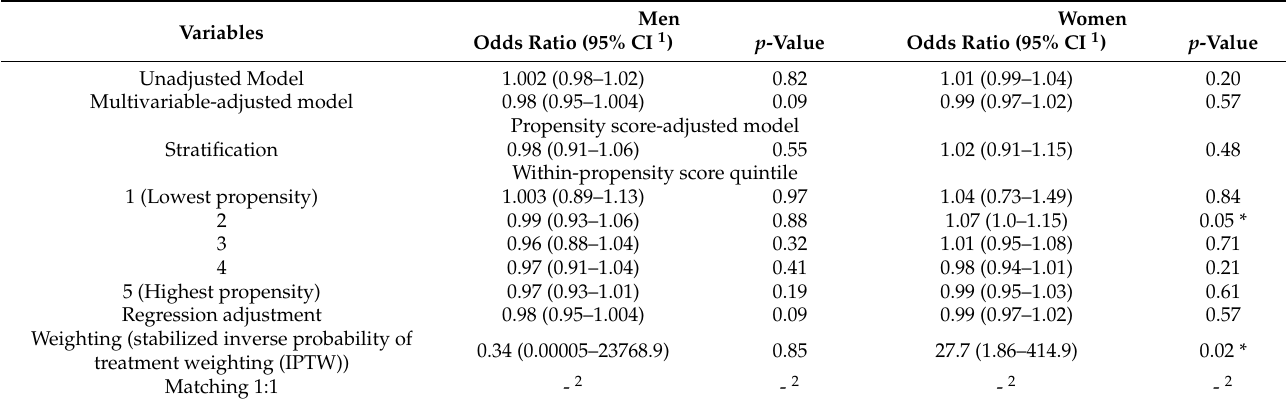
Table 3. Odds ratios for each propensity score analysis to determine the association between number of remaining teeth and bone mineral